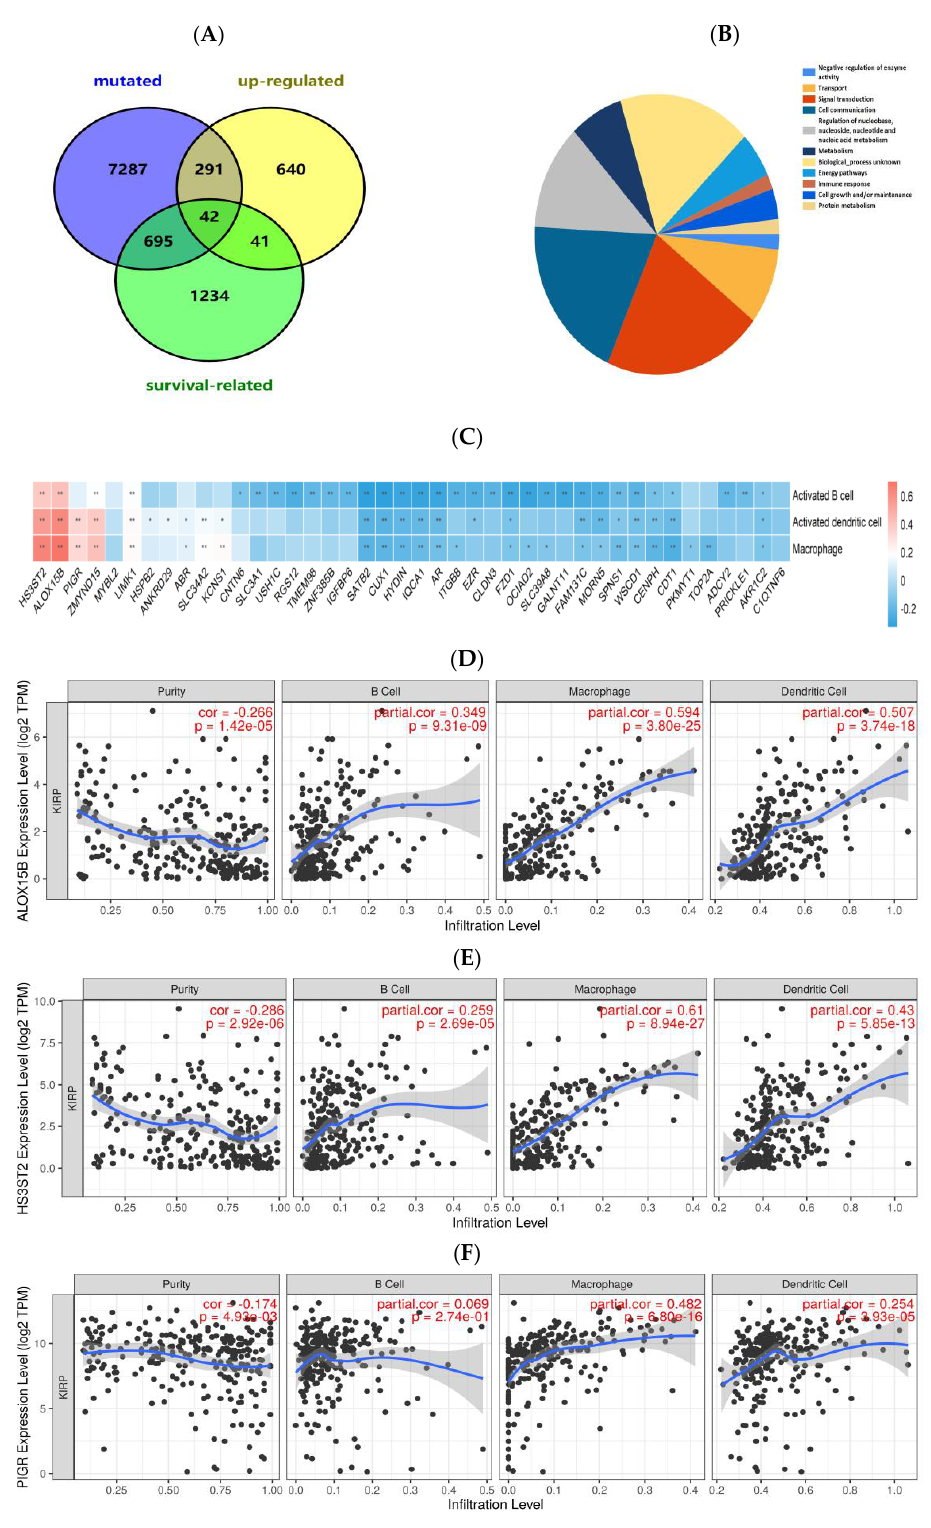
(Figure 5F) indicated that the immunophenotyping of PRCC patients was robust, and the two subtypes were almost totally separated from each other. The proportion of immune subtypes in the age (<60 or >60), gender (male or female) and stage (I–IV) group were calculated and individually displayed (Figure 5G–I).